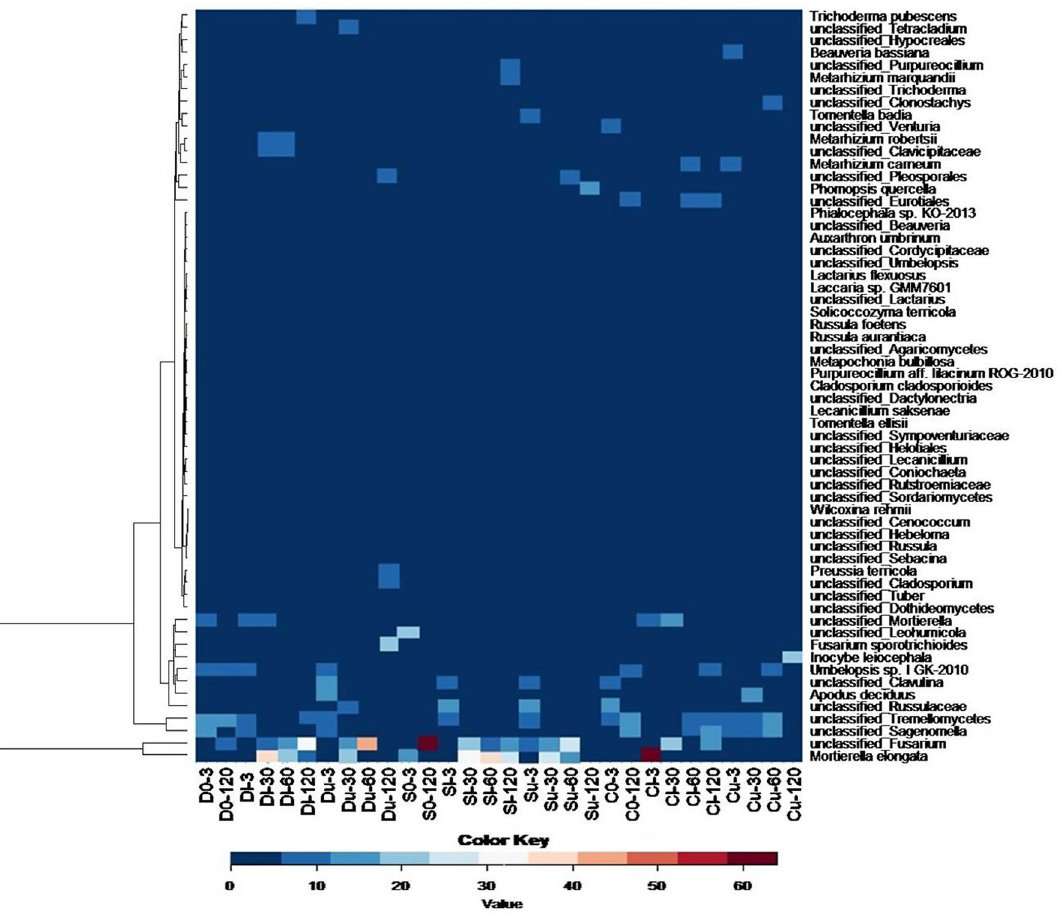
Figure 7. Heatmap of dominant fungal genera (% relative sequence abundance ≥ 2). Changes are displayed on a relative scale with enrichment in red and depletion in